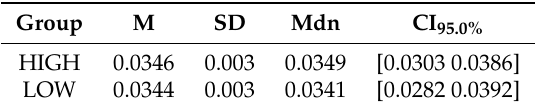
Table A2. EC HIGH and LOW stress-susceptible groups’ TEs. Mean (M), standard deviation (SD), median (Mdn), and 95.0% confidence interval (CI 95.0% ) associated with bootstrap (10,000 simulation runs) 95.0% confidence interval of upper bound CI of participants’ TEs (i.e., TE values associated with p < 0.025)